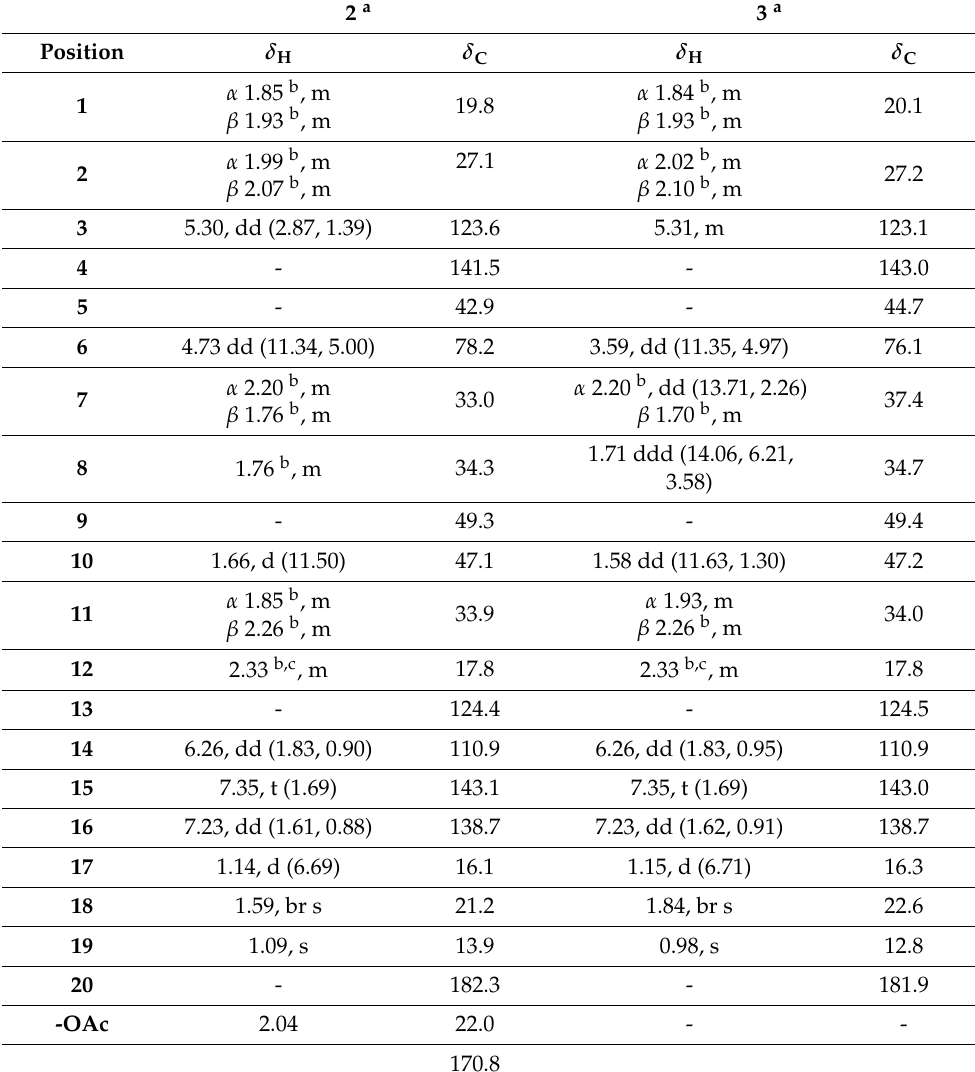
Table 1. 1 H and 13 C NMR spectroscopy data of compounds 2 and 3 ( δ in ppm, J in Hz).